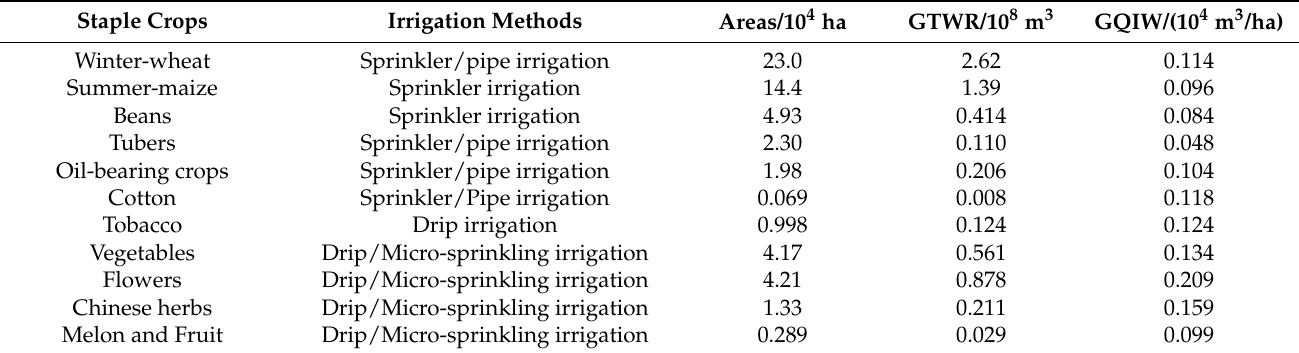
Table 3. Irrigation methods and water demand of main crops in XCA in